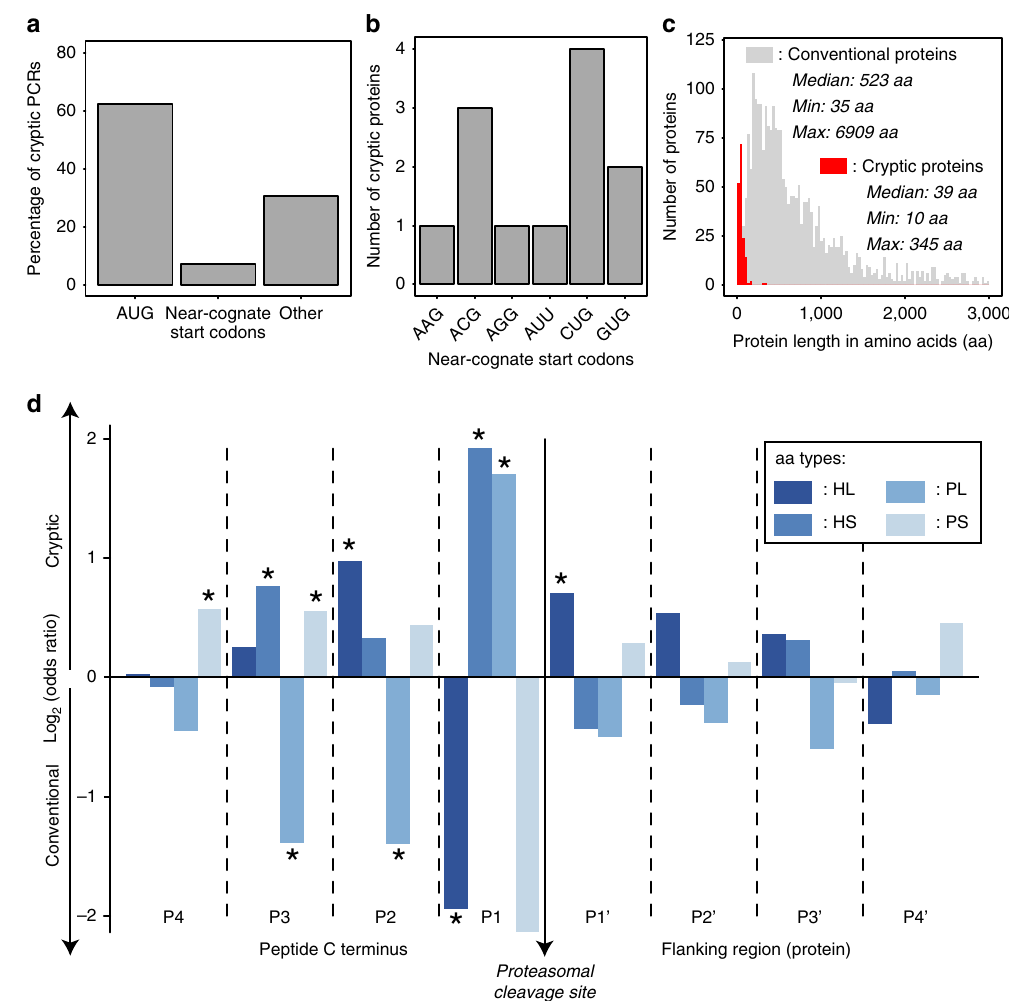
Figure 5 | Features of ORFs coding Crypt. MAPs. ( a ) Most Crypt. PCRs are in-frame with an upstream start codon. To predict the probable start codon of each Crypt. PCR, we sequentially applied the following rules: (i) presence of an upstream AUG within an optimal (GCC[R]CCstartG[V]), strong ([R]NNstartG[V]) or weak (anything else) Kozak context, (ii) presence of an upstream near-cognate start codon within an optimal or strong Kozak context, (iii) any other codon downstream of the first upstream stop codon. Bars represent the percentage of Crypt. PCRs displaying an upstream in-frame AUG, near-cognate start codon or any other codon as a probable initiation codon. ( b ) Bar plot showing near-cognate start codon usage at putative translational start sites of 12 Crypt. source proteins. ( c ) Length distribution of Conv. and predicted Crypt. proteins. Median, minimum (Min) and maximum (Max) observed lengths are indicated on the graph for both types of proteins. Conv. proteins having a length 4 3,000 amino acids are not displayed on the graph. ( d ) Crypt. and Conv. MAPs do not have the same amino-acid composition at their C termini. Amino acids (aa) were classified in four categories: Hydrophobic/Large (HL), Hydrophobic/Small-Medium (HS), Polar/Large (PL) and Polar/Small-Medium (PS) 44 . For the MAP C terminus (positions P4 to P1) and its C-terminal flanking region (positions P1 0 to P4 0 ), we compared the usage of those four aa categories at each position between Crypt. and Conv. MAPs. The graph displays the log 2 (odds ratio) and significant differences are marked with an asterisk (* P o 0.05; two-sided Fisher’s exact